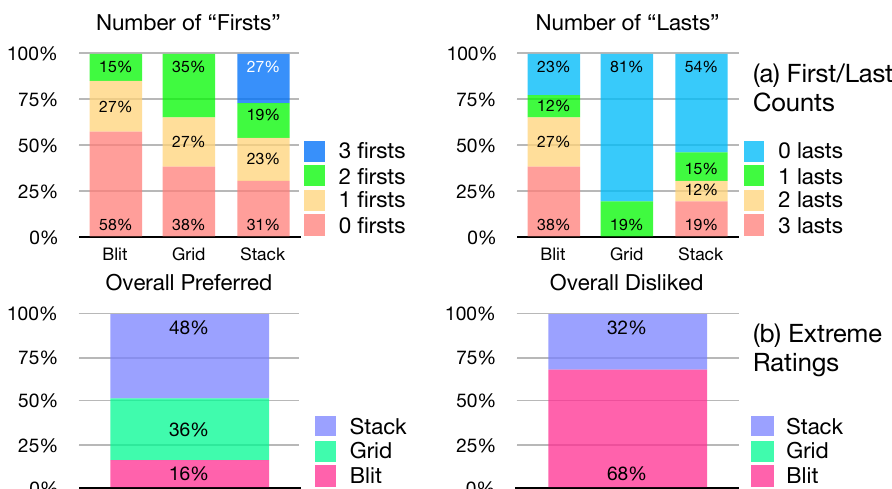
Figure 6. ( a ) Which proportion of participants gave the systems a number of zero to four first or last rankings across all aspects (legibility, ease of use, and visual design); ( b ) which proportion gave the most “firsts” (and therefore “preferred”) or “lasts” (and therefore “disliked”) to each system in the pairwise comparisons.